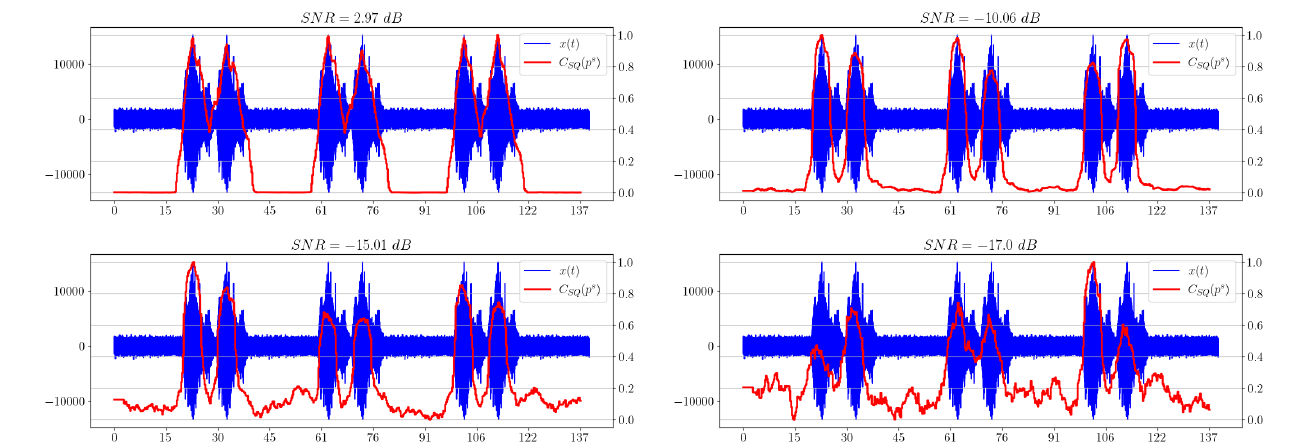
Figure 9. Graphs of statistical complexity for different